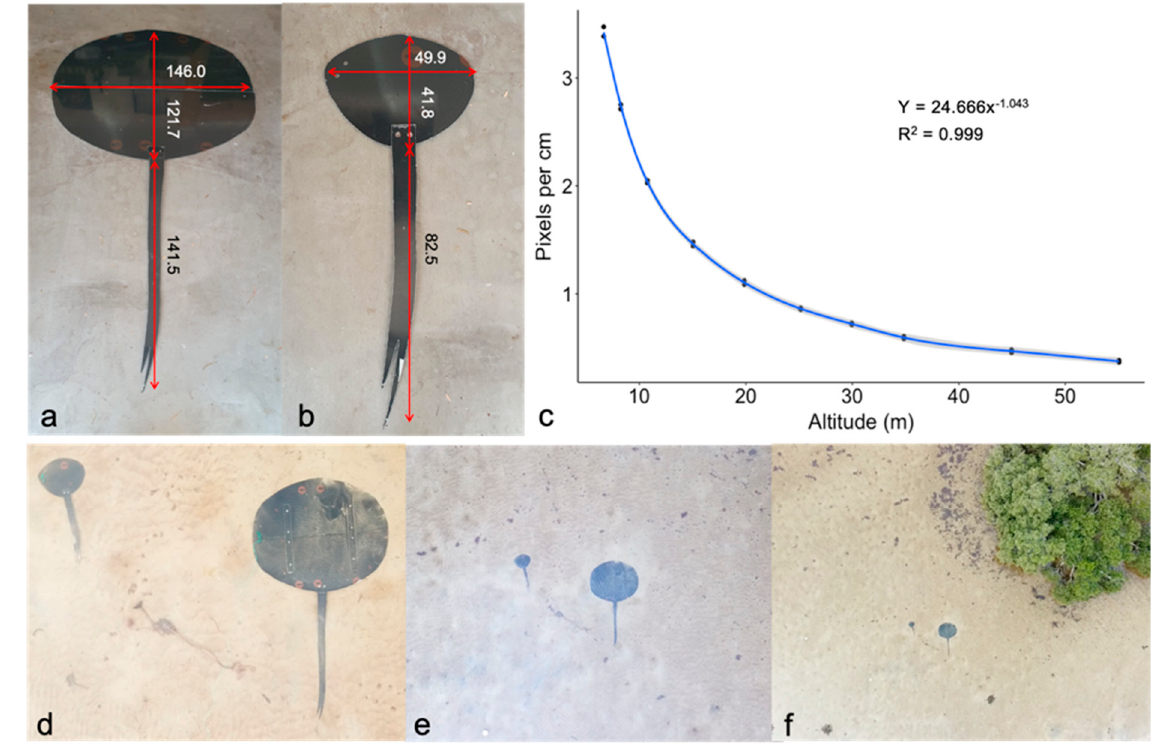
Figure 1. ( a ) Model mature (large) and ( b ) juvenile (small) short-tail stingrays. All measurements are shown in centimeters. ( c ) Calibration curve plotting the pixels per centimeter of the ray models against the drone altitude using measurements from both the small and large models at ten different altitudes. The shaded area represents the 95% confidence intervals. ( d – f ) Drone images of model stingrays. Images were taken in sheltered waters with <10 kph winds. Image ( d ) was taken at 5 m altitude, ( e ) at 20 m altitude and ( f ) at 50 m altitude.